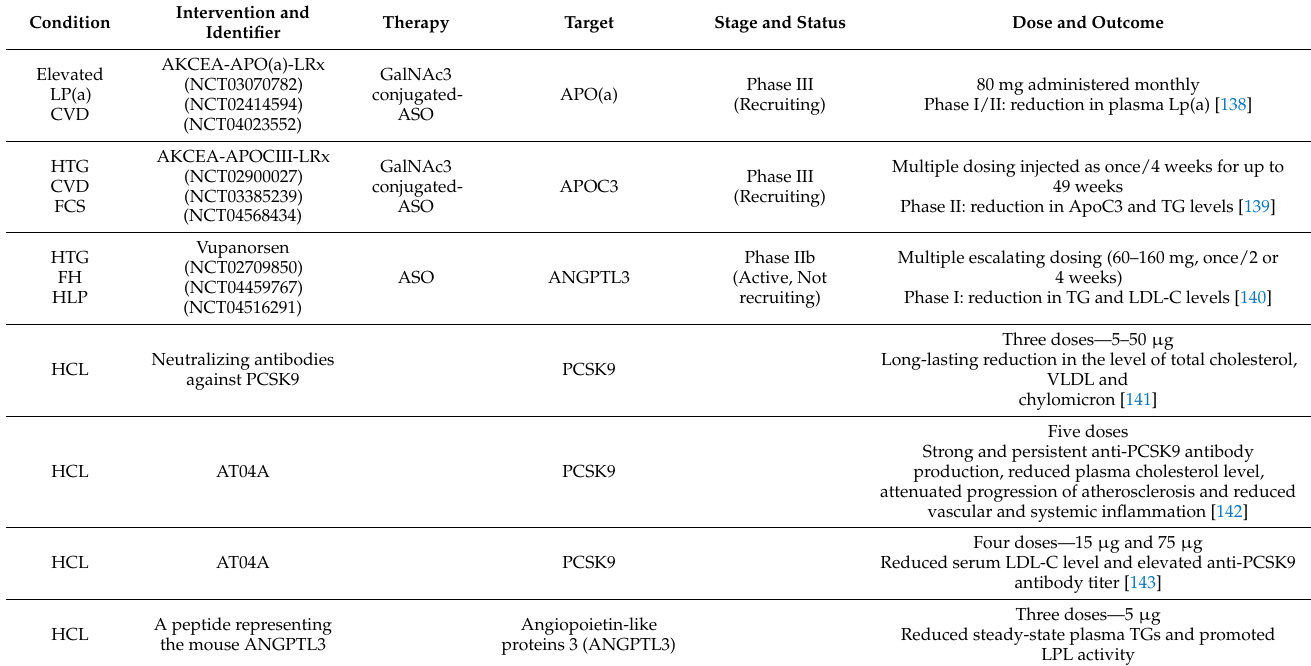
GLP-1: glucagon-like peptide-1; IAPP: Islet amyloid polypeptide; DPP4: dipeptidyl peptidase-4; GIP: glucose-dependent insulinotropic polypeptide; HTN: Hypertension; HF: Heart failure; MI: Myocardial infarction; HCL: Hypercholesterolemia; HoFH: Homozygous familial hypercholesterolemia; HeFH: Heterozygous familial hypercholesterolemia; AngII-KLH: Angiotensin II—keyhole-limpet hemocyanin; PCSK9: Proprotein convertase subtilisin/kexin type 9; ASO: Antisense oligonucleotides; ApoB: Apolipoprotein B; LDL-C: low